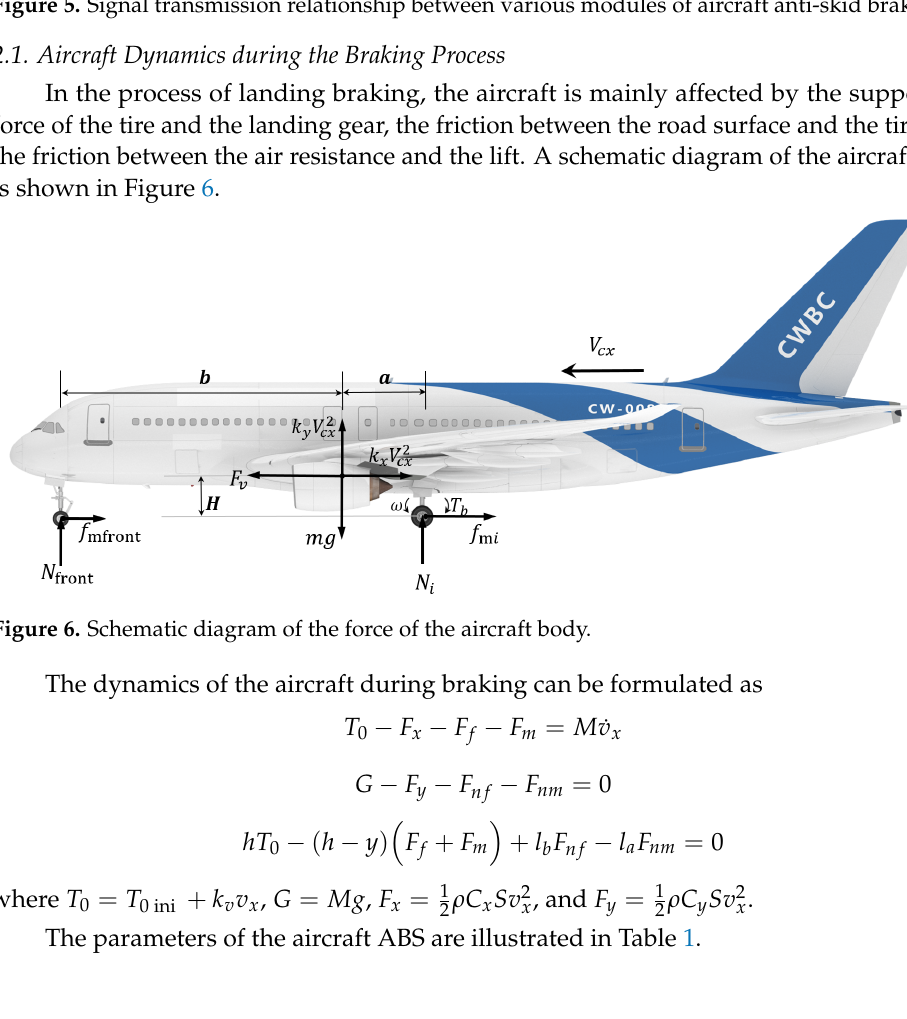
Figure 5. Signal transmission relationship between various modules of aircraft anti-skid brakes.